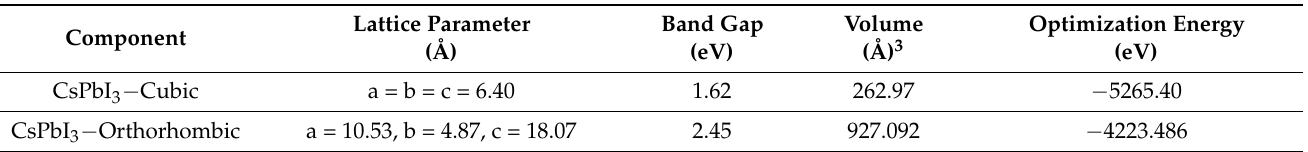
Table 1. Lattice parameters, structure volumes, band gap values, and optimization energies of CsPbI 3 for both cubic and orthorhombic phases.